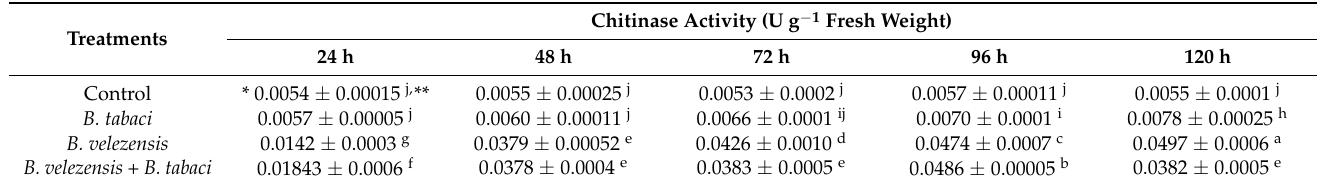
Table 2. The time-course of chitinase activity in squash plants exposed to Bemisia tabaci and Bacillus velezensis, and both agents compared with control.